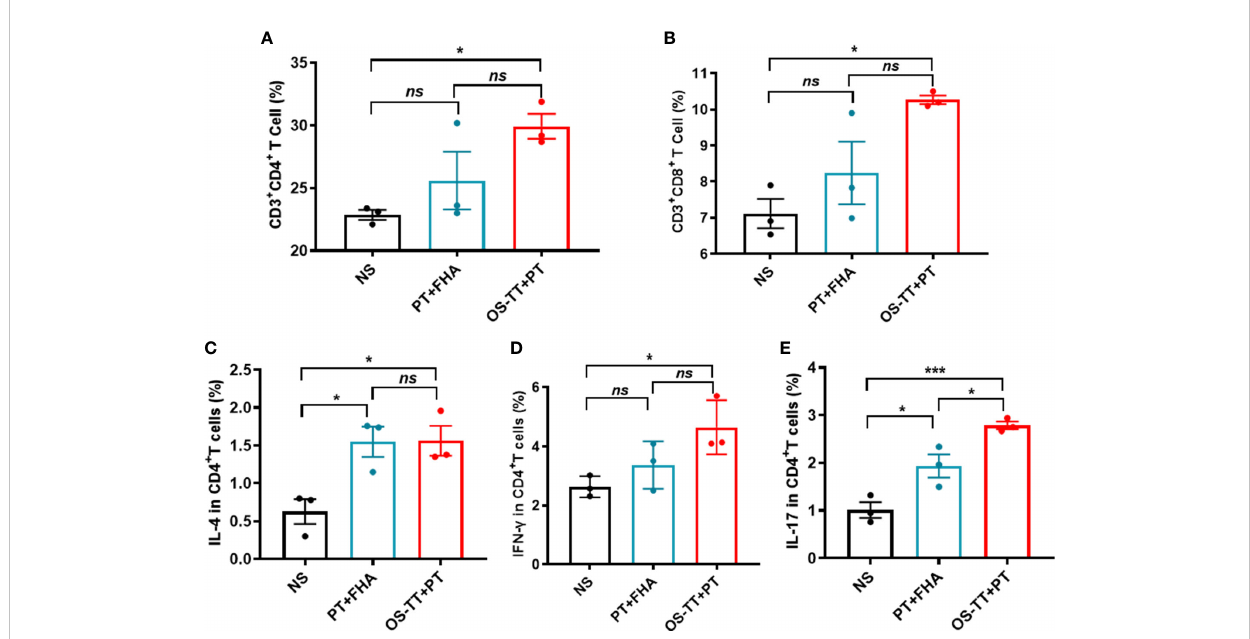
FIGURE 3 Immune responses of OS-TT+PT in mice. Fourteen days after the third immunization, splenocytes were harvested from mice and stimulated with OS-TT+PT. After 48 h, the percentages of CD3 + CD4 + cells (A) ,CD3 + CD8 + cells (B) , IL-4 (C) , IFN- g (D) and IL-17 (E) were determined by FCM. NS: normal saline. Data shown are from one representative of two independent experiments. Data in A-E (n=3) are shown as the mean ± SEM, and signi fi cance was calculated using a one-way ANOVA with multiple comparison tests ( ns , not signi fi cant; * p < 0.05; *** p <